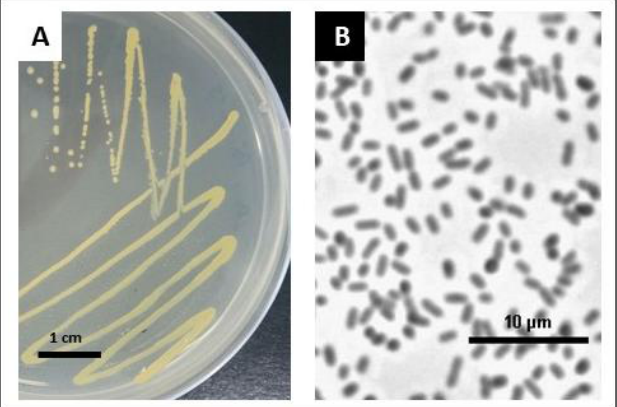
P. agglomerans and P. vagans (Table S1, Figure S1 in Supplementary File S1). We named the isolated strain SRS89.